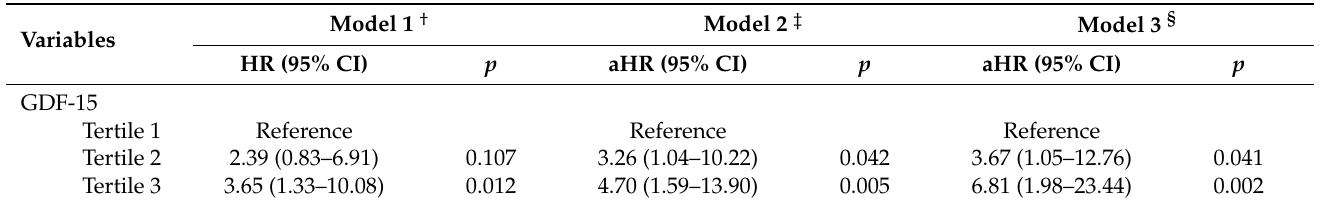
Table 2. Association between GDF-15 and mortality in Cox proportional hazards analysis.